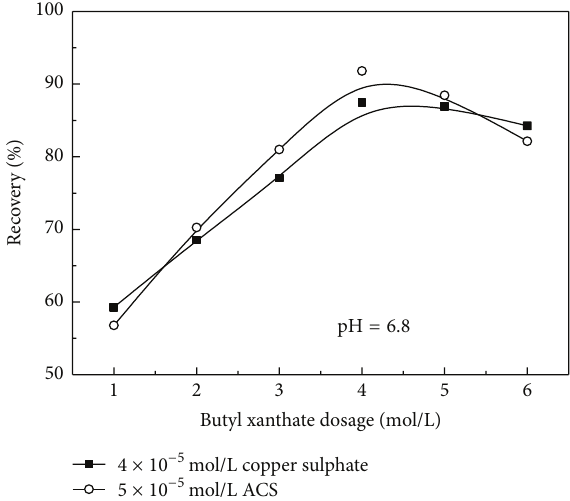
Figure 3: Effects of activator types and their concentration on sphalerite recovery.